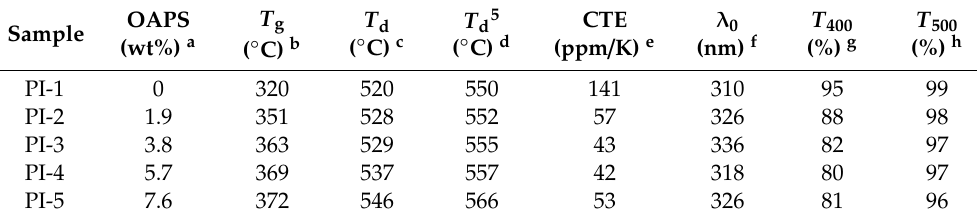
Figure 1. ( a ) DMA, ( b ) DSC, ( c ) TMA, and ( d ) TGA curves of pure PI and PI-POSS hybrid films. Table 1. The thermal and optical properties of pure PI and PI-POSS hybrid Table 1. The thermal and optical properties of pure PI and PI-POSS hybrid films.